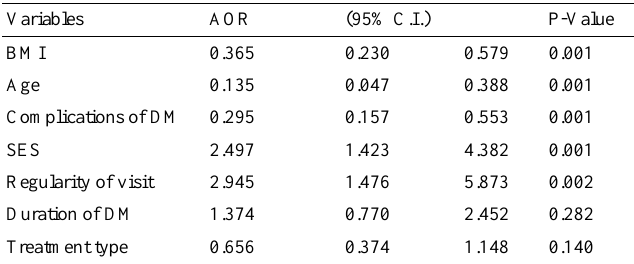
Binary logistic regression for Physical Component score